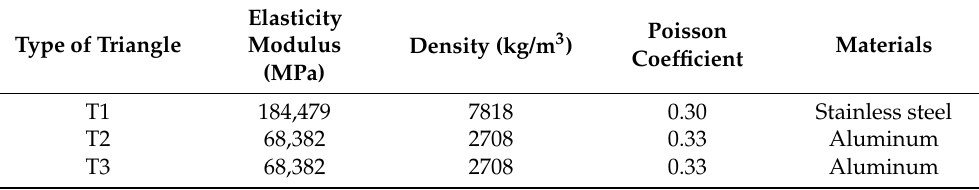
Table 2. The engineering constants of triangle materials. Type of Triangle